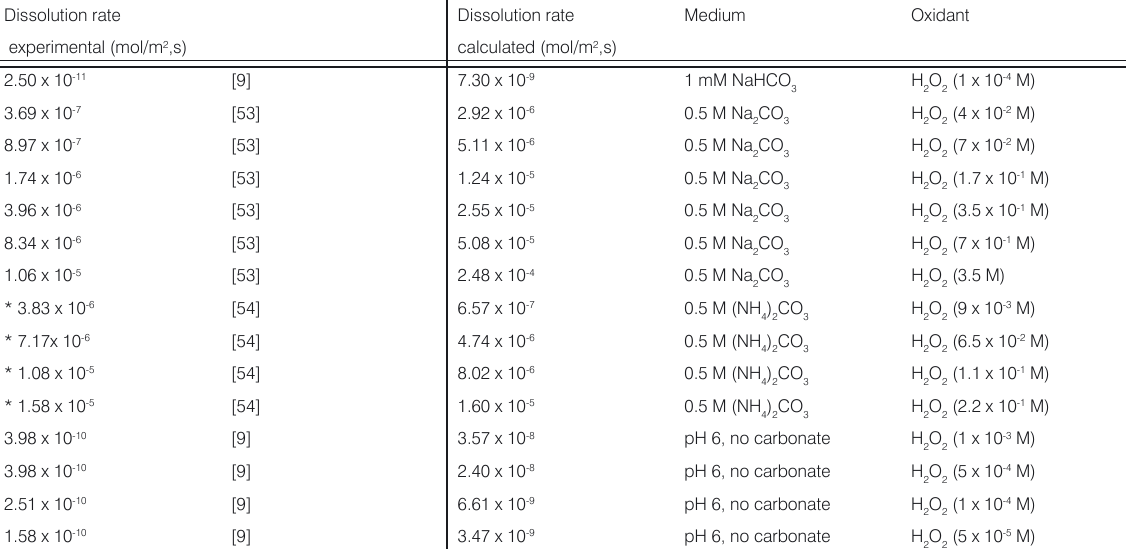
Table 2. Experimentally determined dissolution rates and dissolution rates calculated based on the rate constants for oxidation and dissolution in different